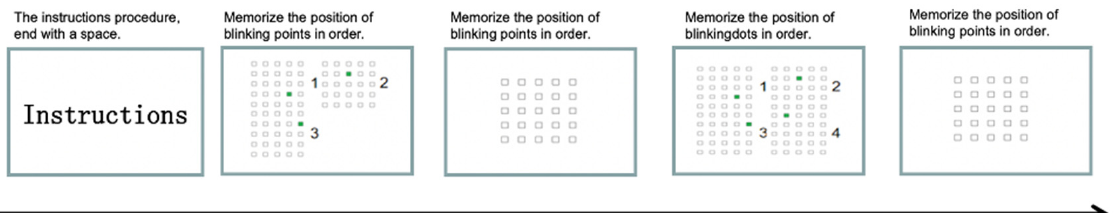
Figure 3. Experimental flow chart of the spatial working memory task in non-orienteering scenarios. 1. the guidance instructions before the start of the experiment, press “space” end; 2. according to the screen prompts for non-directional scenes experimental year: the location of the flash set in order of memory (3 flash points); 3. according to the memory click the corresponding luminous point position; 4. screen prompts for non-directional scenes experimental year: memorize the location of the flashing set in order (4 flashing